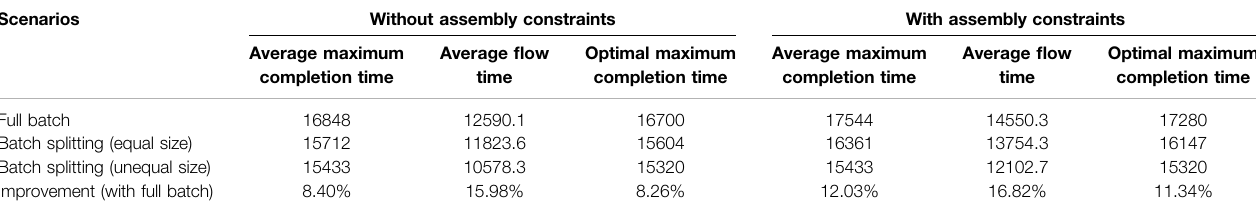
TABLE 5 | 4 × 6 lot-splitting scheduling results